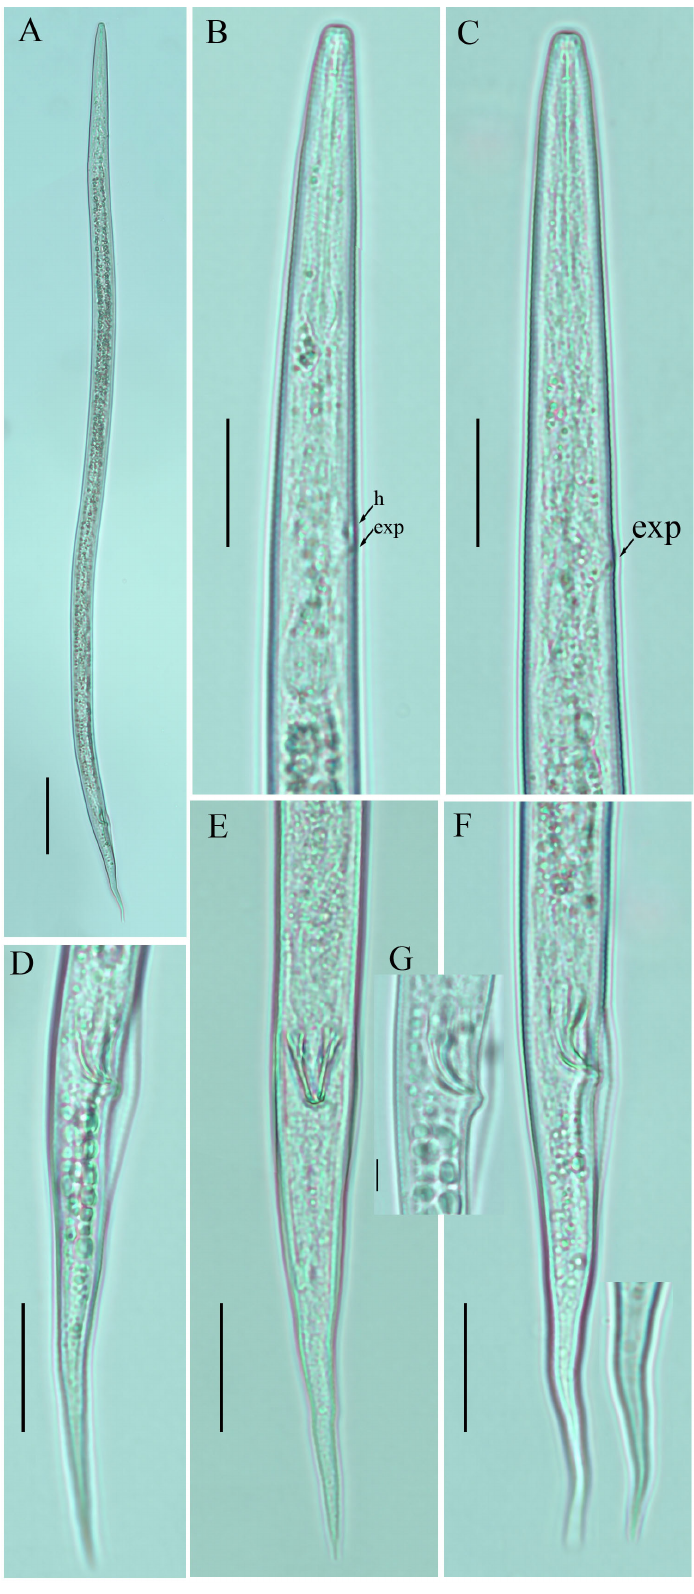
Figure 4. Photomicrographs of male Ditylenchus tenuidens Gritsenko [41] ( A ) Entire body; ( B , C ) pharyngeal region; ( D – F ) tail region; ( G ) spicule. Scale bars: ( A ) 50 µm; ( B – F ) 20 µm; ( G ) 5 µm. Arrows: (h) hemizonid; (exp) secretory–excretory pore.